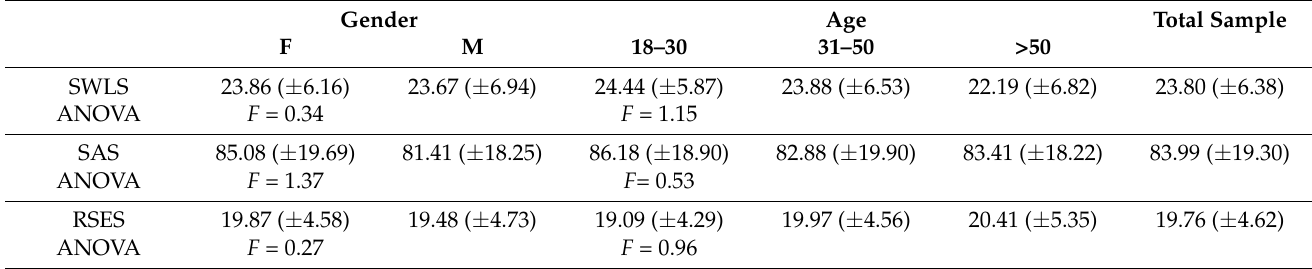
Table 2. Overall means (SD) by gender, age, and F statistics of ANOVA between groups. Gender